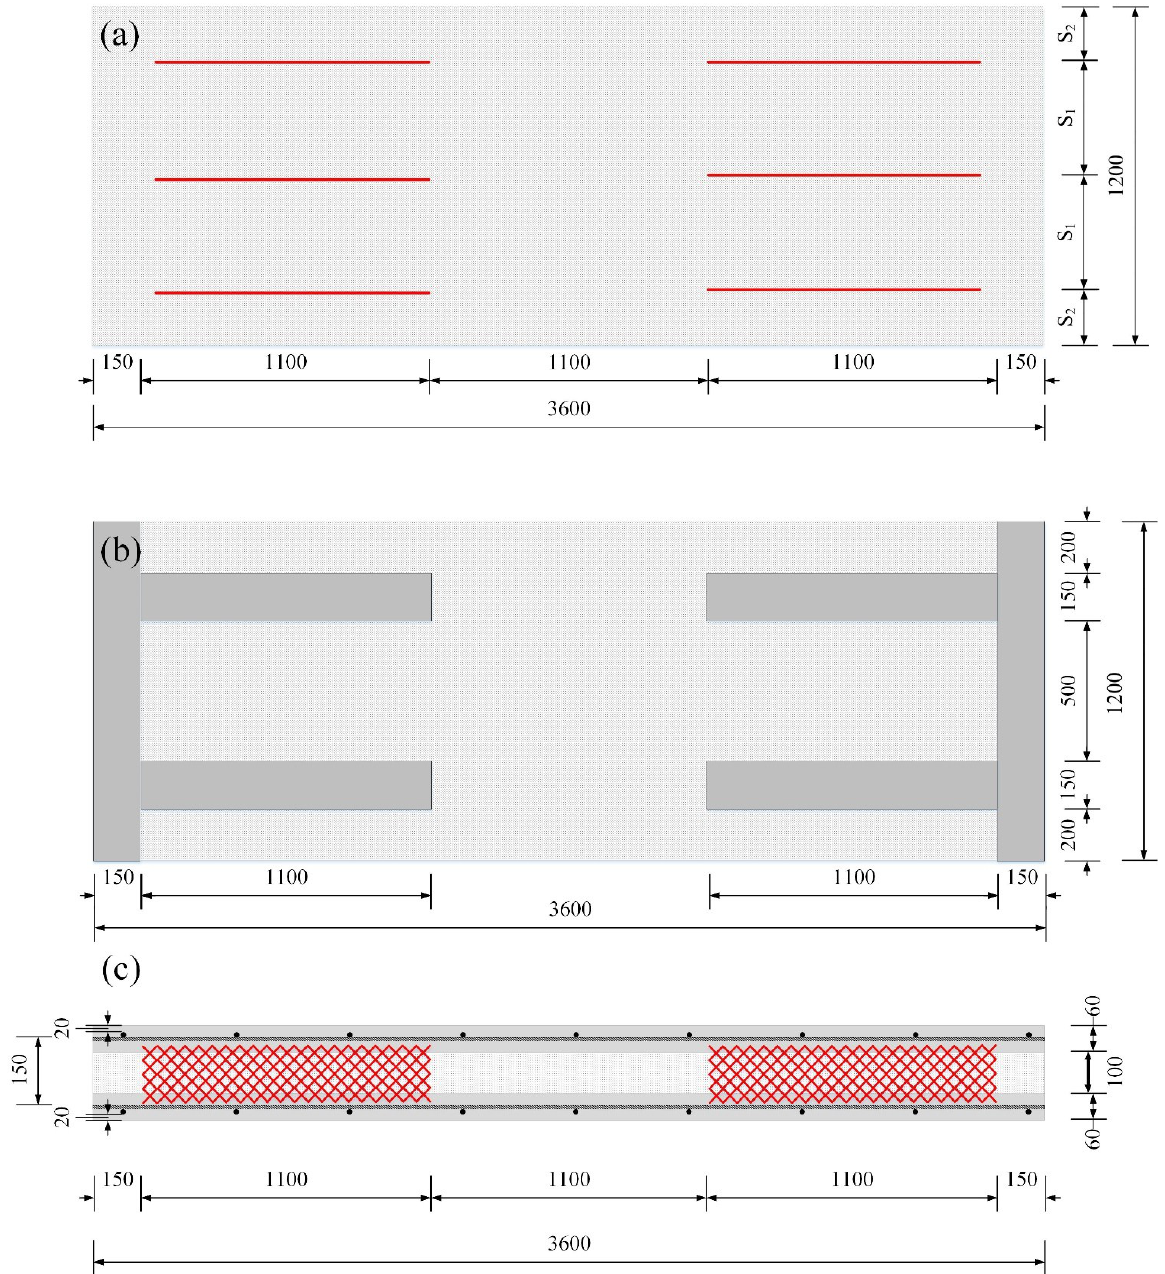
Figure 3. Dimensions of the specimens: ( a ) typical plan; ( b ) XPSC plan; ( c )